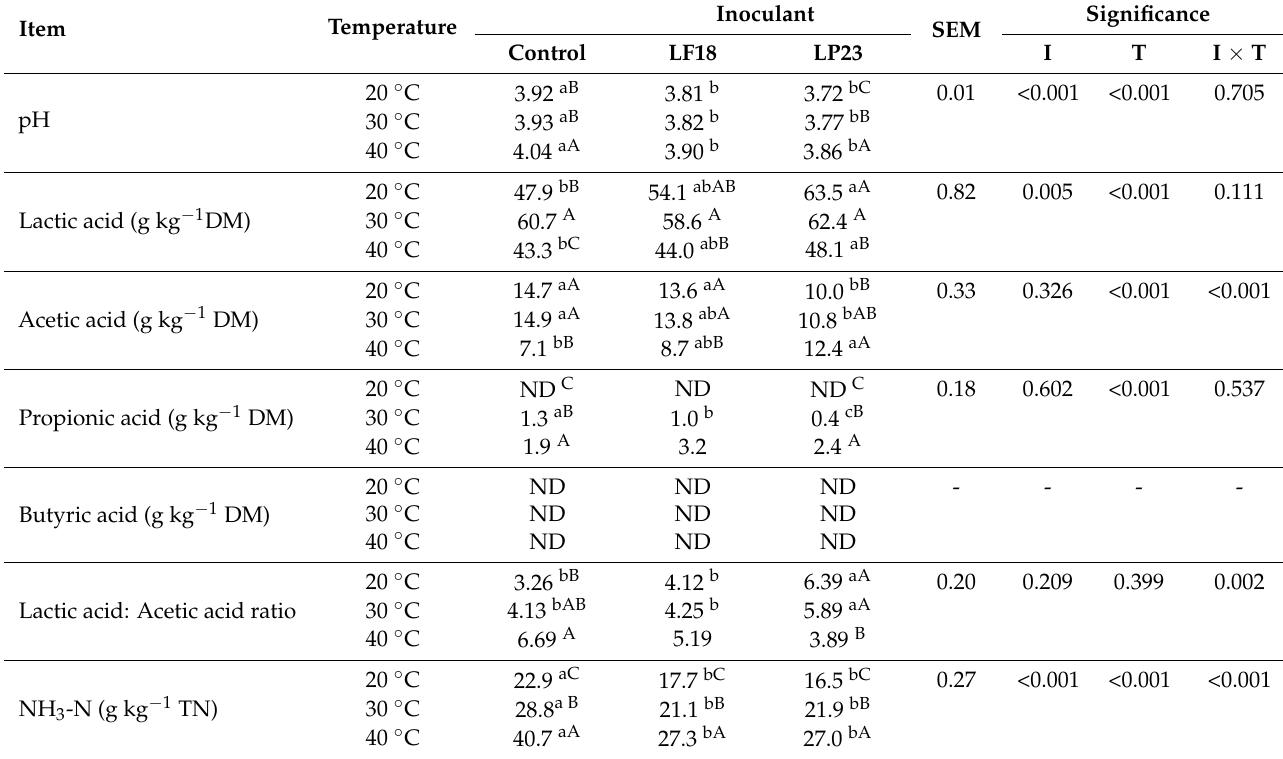
Table 1. Fermentation characteristics of sorghum